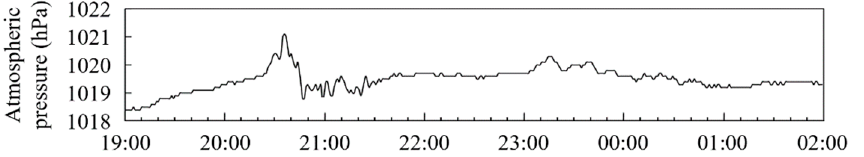
Figure 14. Atmospheric pressure observed every minute at Uken on Amami Oshima Island, Kagoshima, Japan, using the IoT sensor “Soratena” produced by Weathernews, from 19:00 on 15 January to 02:00 on 16 January 2022 (JST).